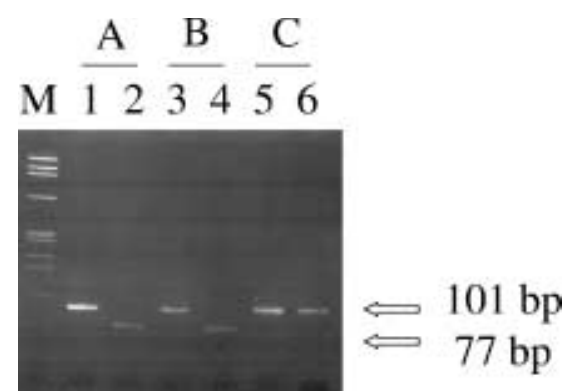
Fig. 1. Detection of the S249C mutation of FGFR3 using amplifi- cation created restriction site by PCR. M: HaeIII-digested øX 174. A: normal blood DNA. B: DNA from cervical carcinomas. C: DNA with an artificially created S249C mutation. Lanes 1, 3 and 5 show the amplification products before BsrBI digestion. Lanes 2, 4 and 6 show the amplification products after BsrBI digestion.